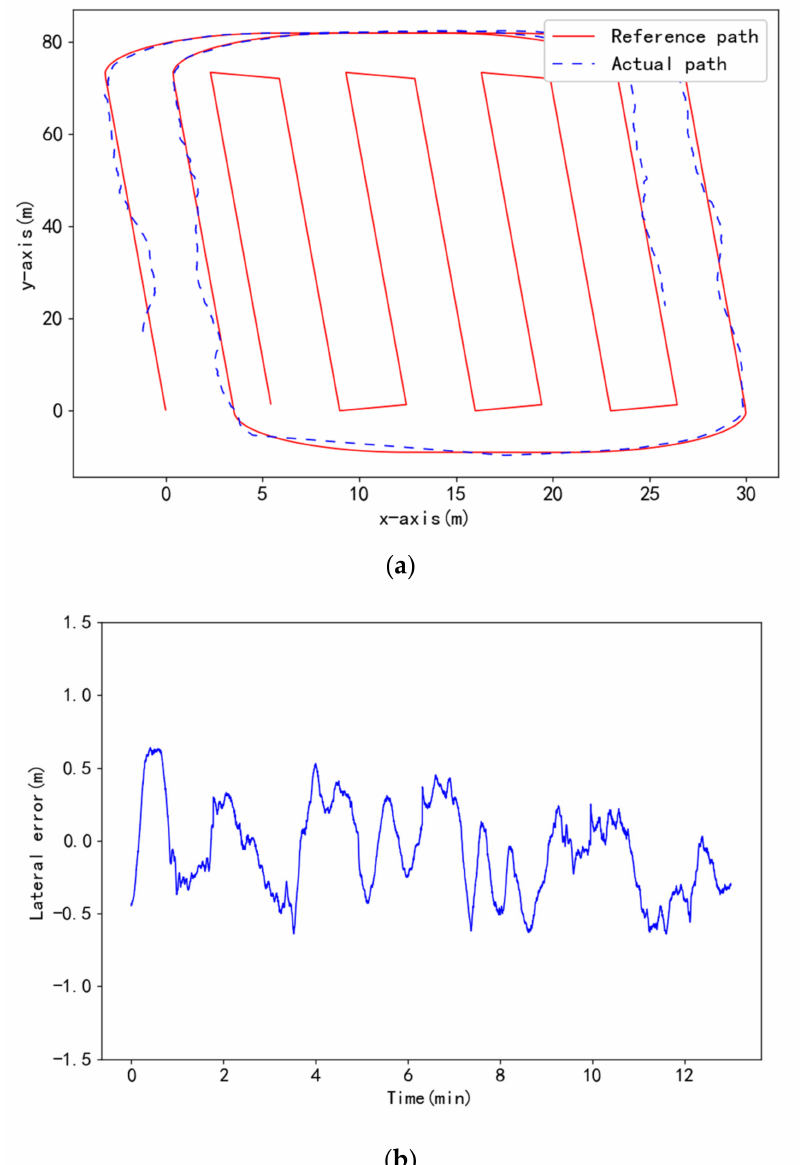
Figure 15. Path tracking result of the combine harvester. ( a ) Tracking trajectory of the combine harvester; ( b ) Lateral error of path tracking for the combine